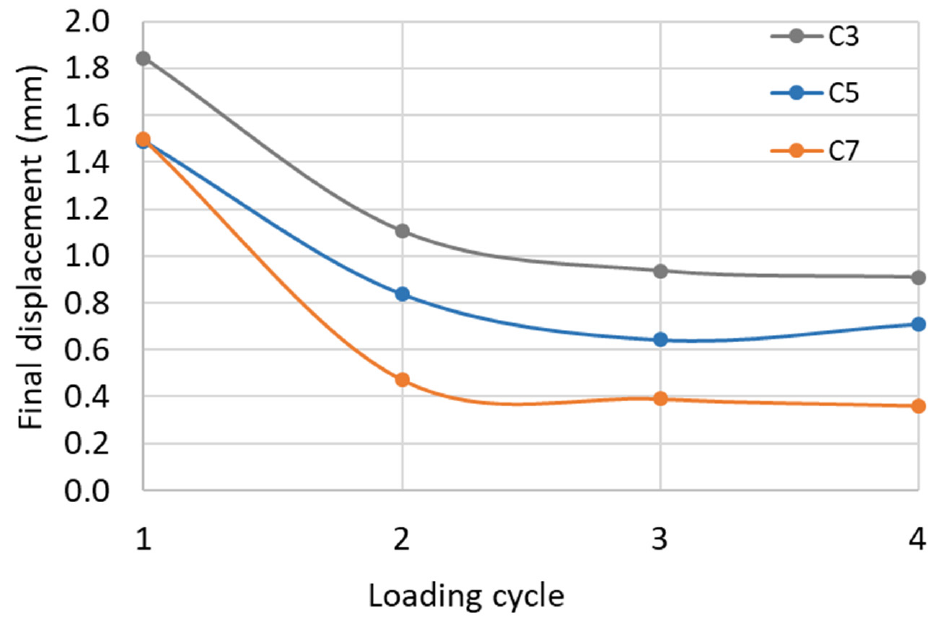
Figure 7. Vertical displacement at the end of each loading cycle. Based on the field of deformation data for each of the series, some insight can be gained. As the load cycles progressed, from first to fourth, and stresses increased, the trends of deformation for each mixture type were amplified, meaning that the end of the last cycle can offer much information regarding broader behaviour, such as non-localised behaviour. Figure 8 enables such an insight with an overlay of the vertical displacement fields on the asphalt’s surface. Firstly, it is visible that the mixture with 3% cement content was the most flexible, in terms of the range of vertical deformation being around 9 mm. Additionally, there was visible localised behaviour without the possibility of a proper stress distribution in an area wider than the input load. This suggests a failure of the lower layers beneath the load and a lack of stiffness to enable a wider distribution of stresses. With an increase of cement content to 5% and 7%, the behaviour significantly changed, showing clear signs of greater stiffness, which was most visible for the lower range of deformation within the entire surface. It should be noted that the differences in behaviour between 5% and 7% cement content on the system level were evidently smaller than on the material level. Namely, the total range of deformation was within 0.5 mm (around 10%), and there was a gradual decrease in deformation away from the load introduction area. The 7% cement content system showed greater stiffness as there was a smaller area within the 2.4 to 3.6 mm range, which was to be expected due to the higher modulus value of the supporting layer. Nevertheless, the use of 7% did not seem to offer large enough benefits in comparison to the 5% cement content